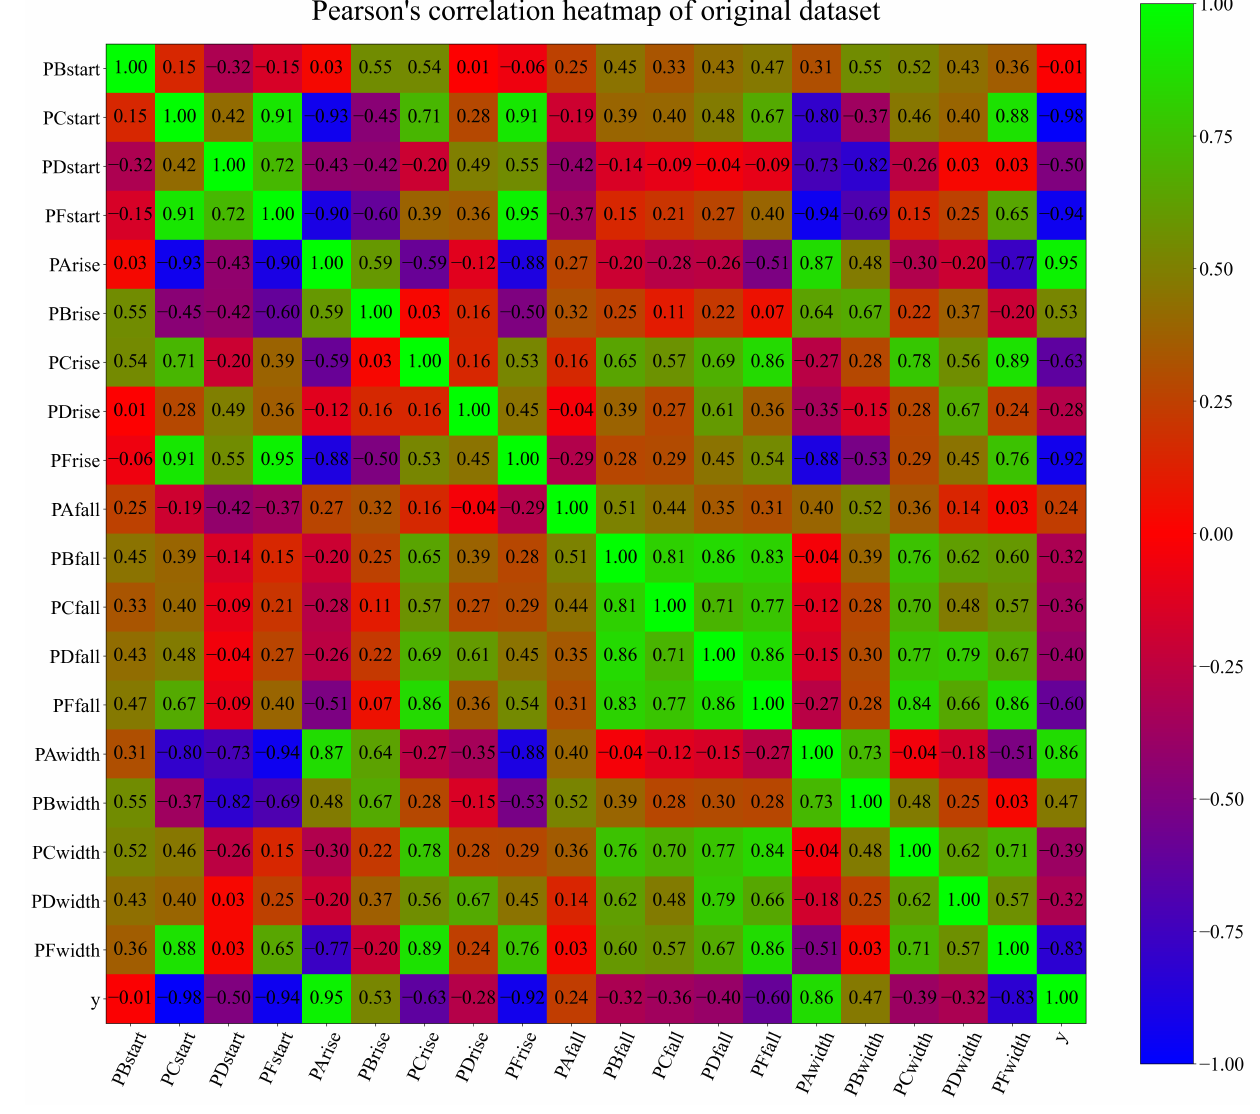
Figure 3. Pearson’s correlation heat